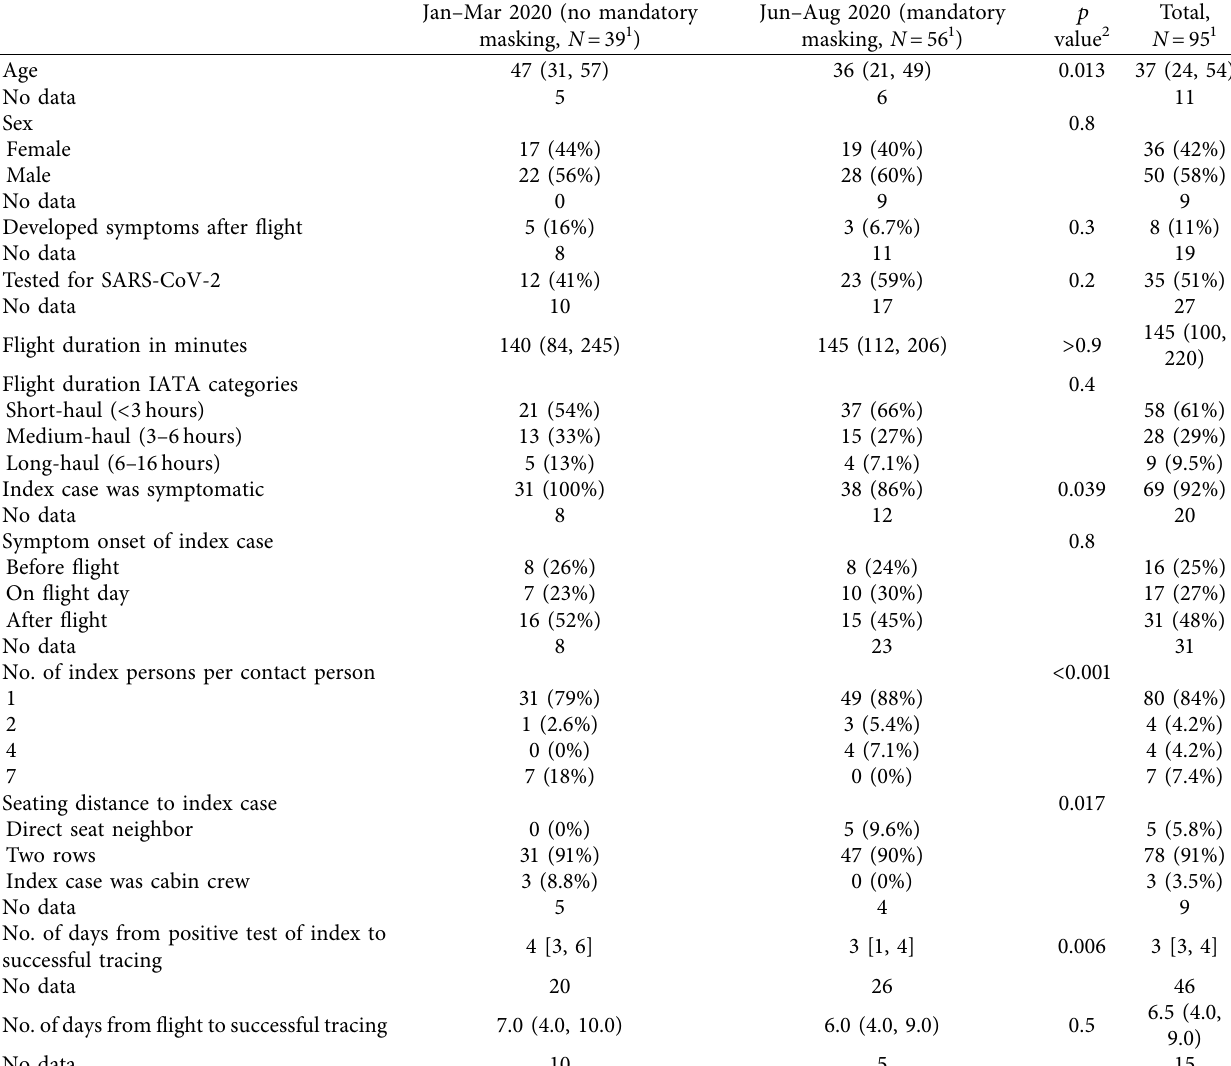
Table 1: Characteristics of all contact persons included for the calculation of attack rates ( n � 95), COVID-19 flight contact tracing study, Germany, 2020.